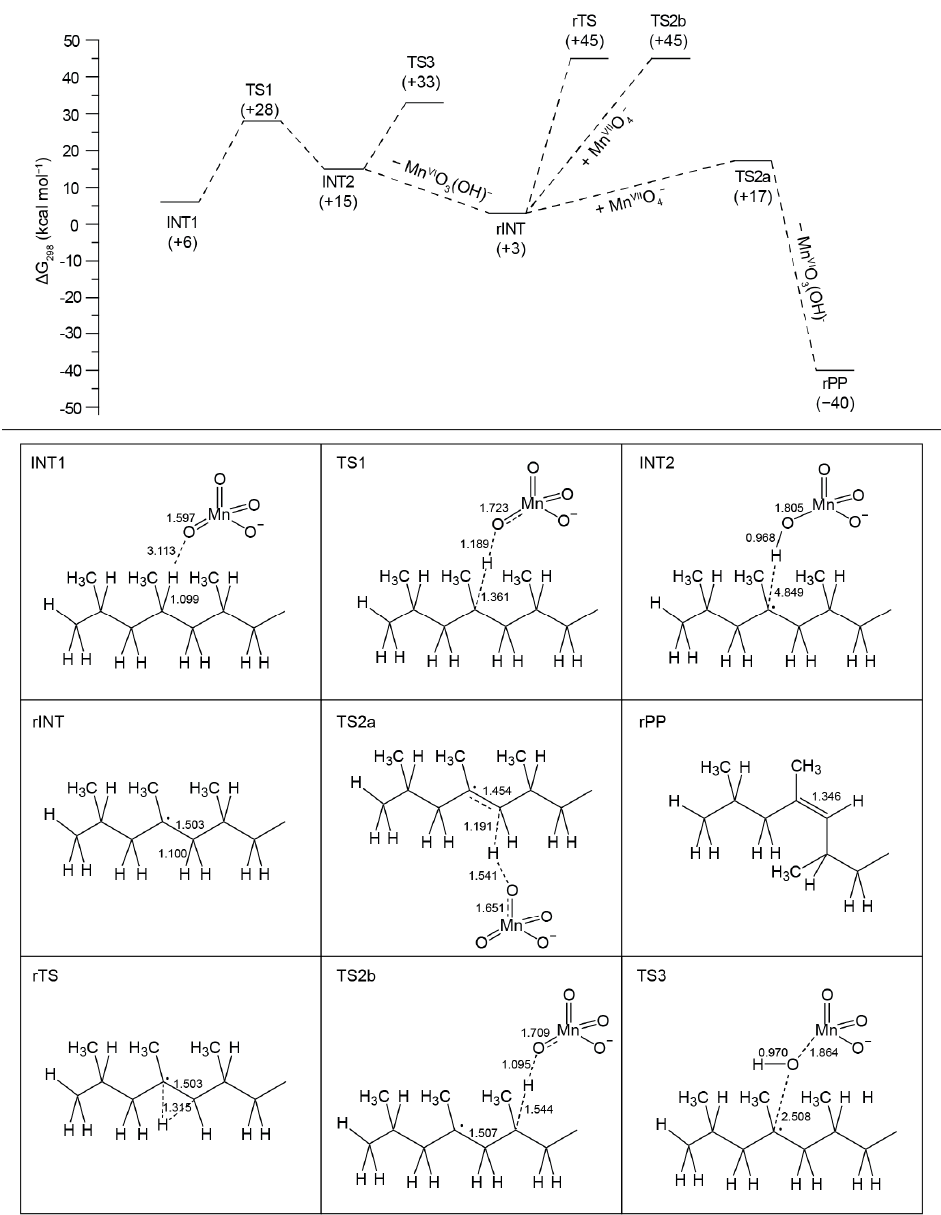
Figure 2. ( Top ) Potential energy surface for the oxidation of PP by MnO 4 − at the B3LYP/LanL2DZ level of theory for Mn and the B3LYP/6-31++G(d,p) level of theory for non-metal atoms. All energies are in kcal/mol and relative to those of the free reactants. ( Bottom ) Structures of intermediates (INTs) and transition states (TSs); the unit of bond distance is Å.